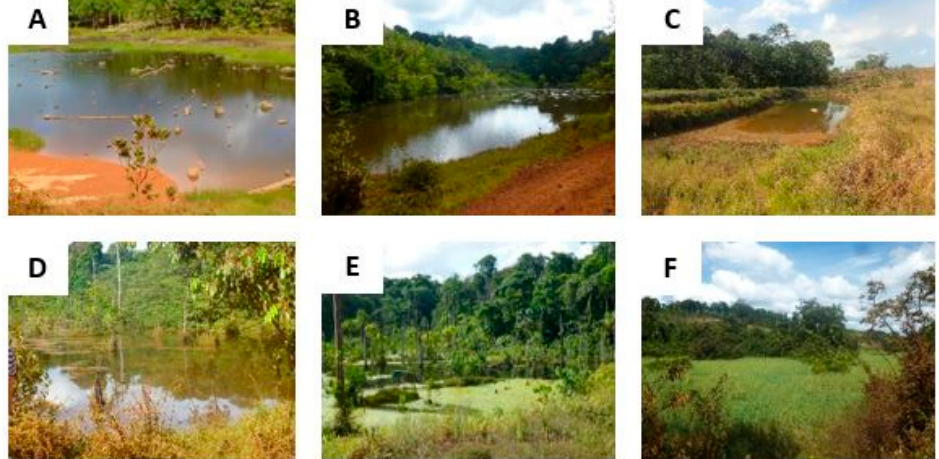
Figure 8. Various types of vegetated wetlands encountered in the Amazon region, more specifically in a rural forested area. ( A , B ) = poorly vegetated ponds; ( C ) = man ‐ made water reservoir located at the fringe of the forest; and ( D – F ) = poorly to strongly vegetated swamps with few trees and dense herbaceous vegetation.